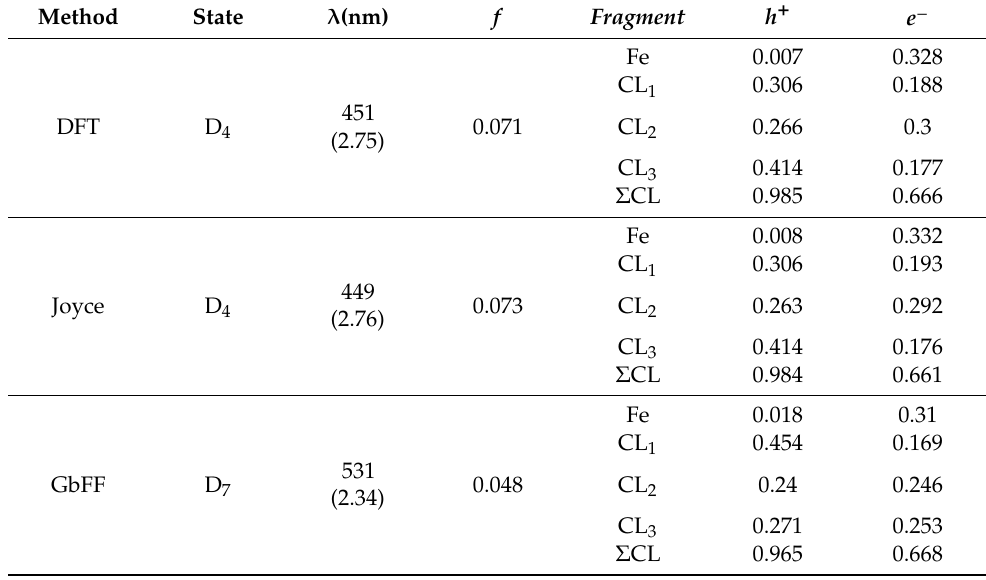
Table 3. Excitonic properties for the lowest-energy most intense transition involved in the ( 2 LMCT) band of the static DFT, J oyce and GbFF simulated spectra represented in Figure 6: state involved (D i ), wavelengths (nm) and energies (eV, within parenthesis), oscillator strengths ( f ); and fraction of the hole ( h + ) and electron ( e − ) localizations on the central metal ion (Fe) and equivalent carbene ligands (CL i ) fragment as obtained from Mulliken population analysis of the NTOs. Note that the hole / electron fraction localized along the boron atoms and phenyl groups are not reported here due to their negligible values. All excitonic properties have been estimated at the TD-B3LYP* / 6-311G* level. Method State λ (nm) f Fragment h + e − Fe